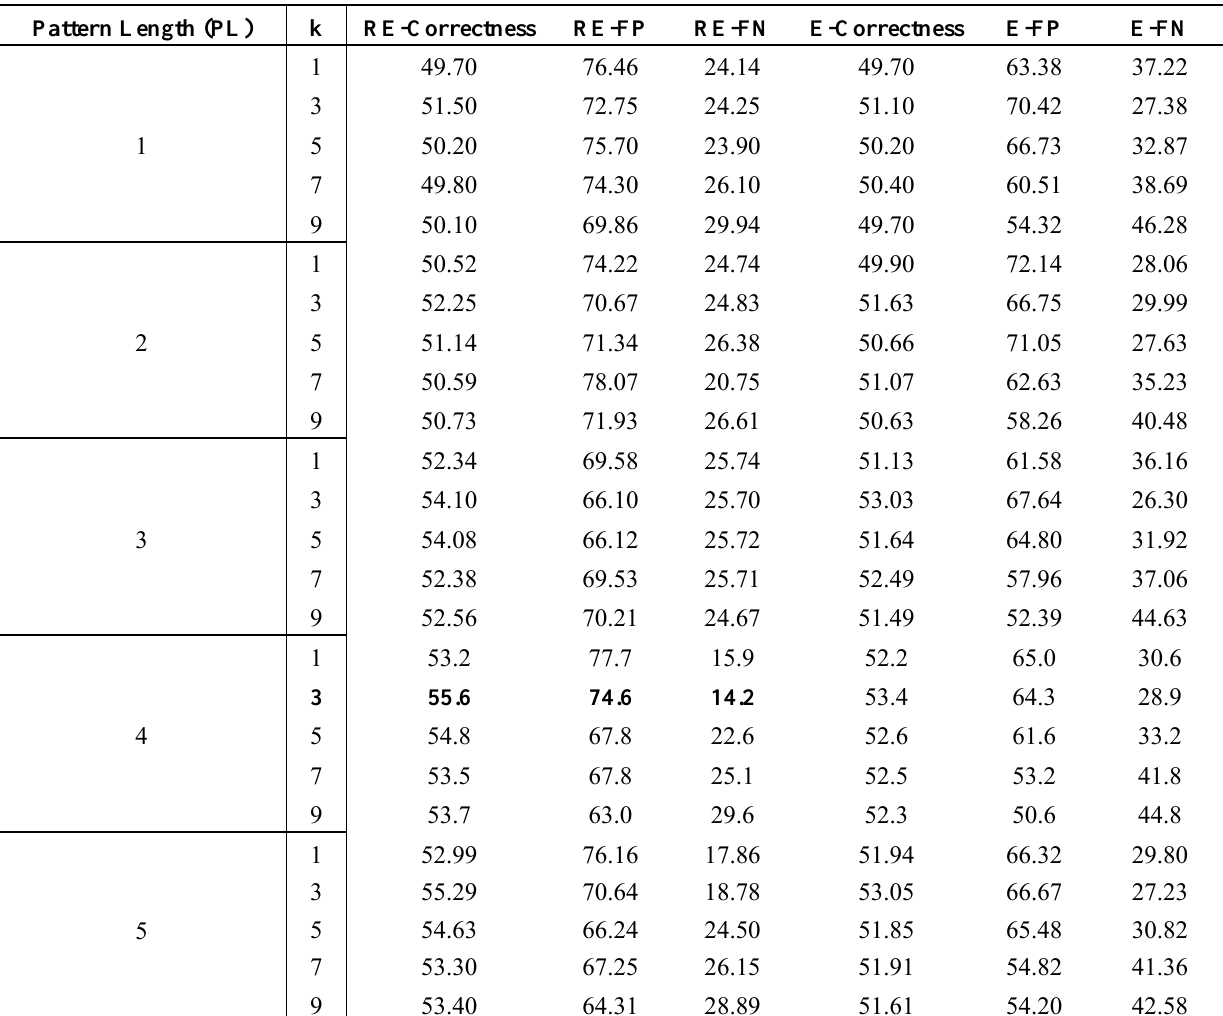
Table 4. Experimental results of k NN classifier